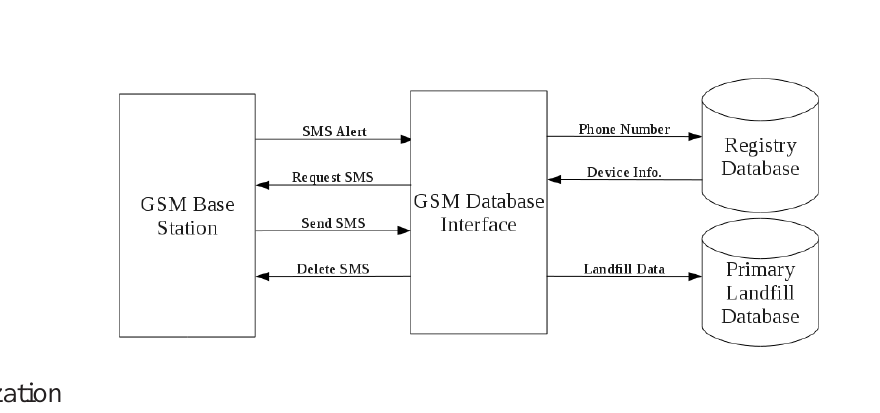
Figure 4. Block diagram showing the interactions between the GSM base station, the